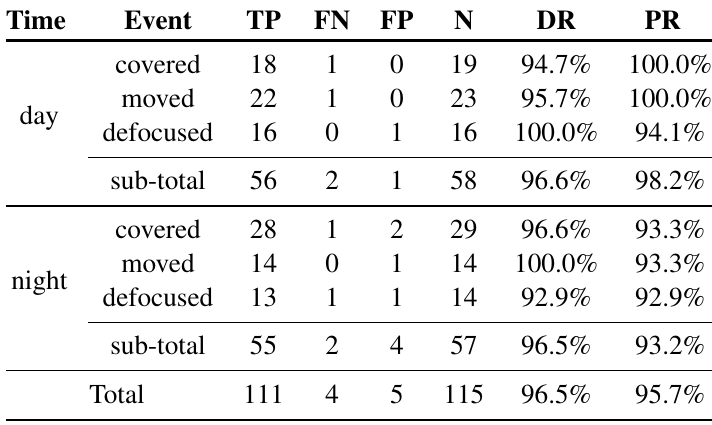
Table 5. Tamper detection accuracy of the proposed algorithm.